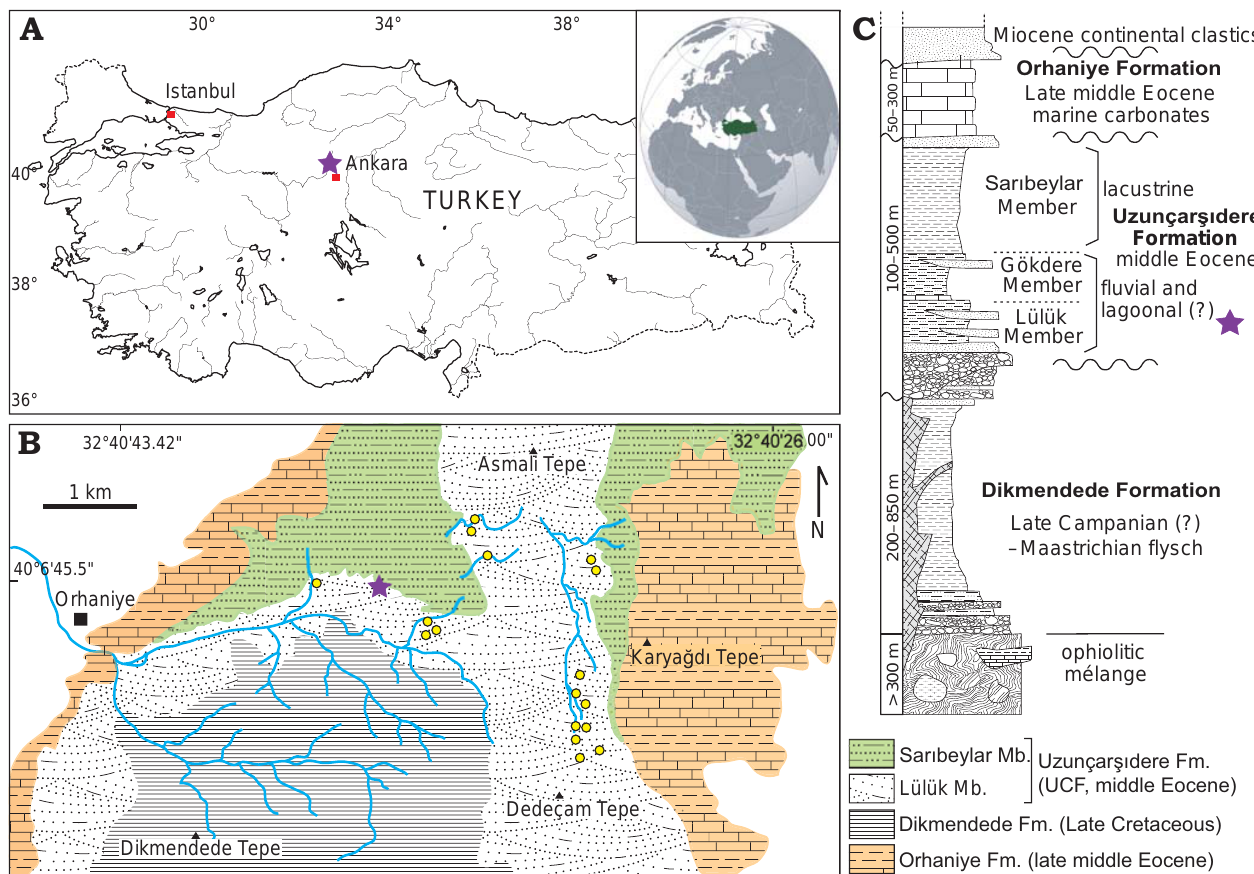
Fig. 1. Map of Turkey with the location of the Orhaniye Basin in Central Anatolia ( A ), geological map of the Orhaniye Basin ( B ) showing the fossil local- ity that yielded the astragalus described here, and a synthetic log ( C ) showing the succession of lithological units exposed in the Orhaniye Basin. Purple stars indicate the location of the fossil site that yielded